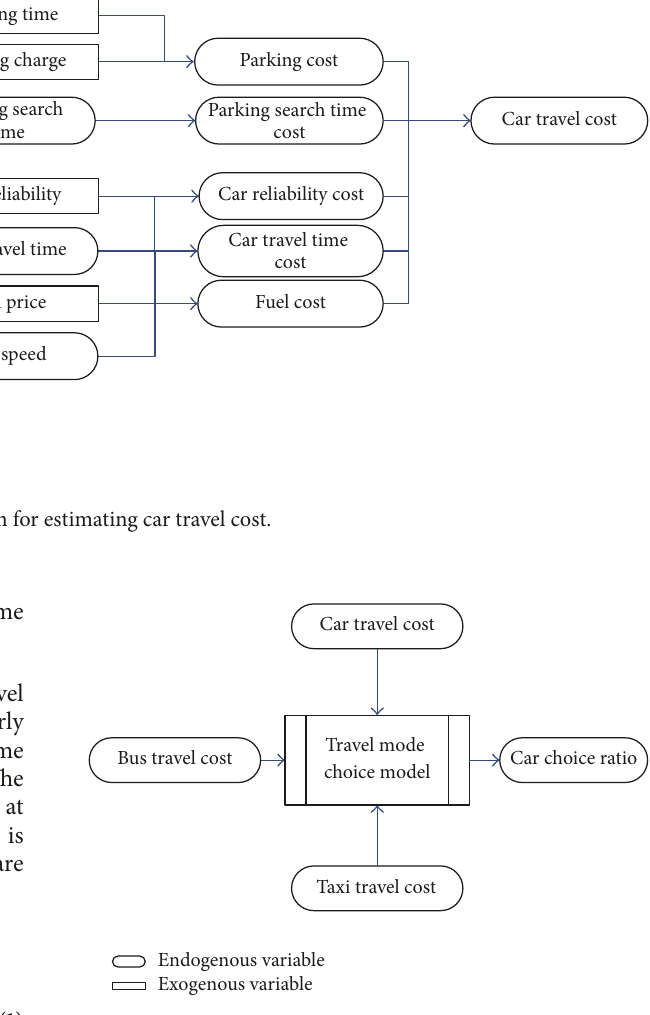
Figure 3: Subsystem for the choice of travel